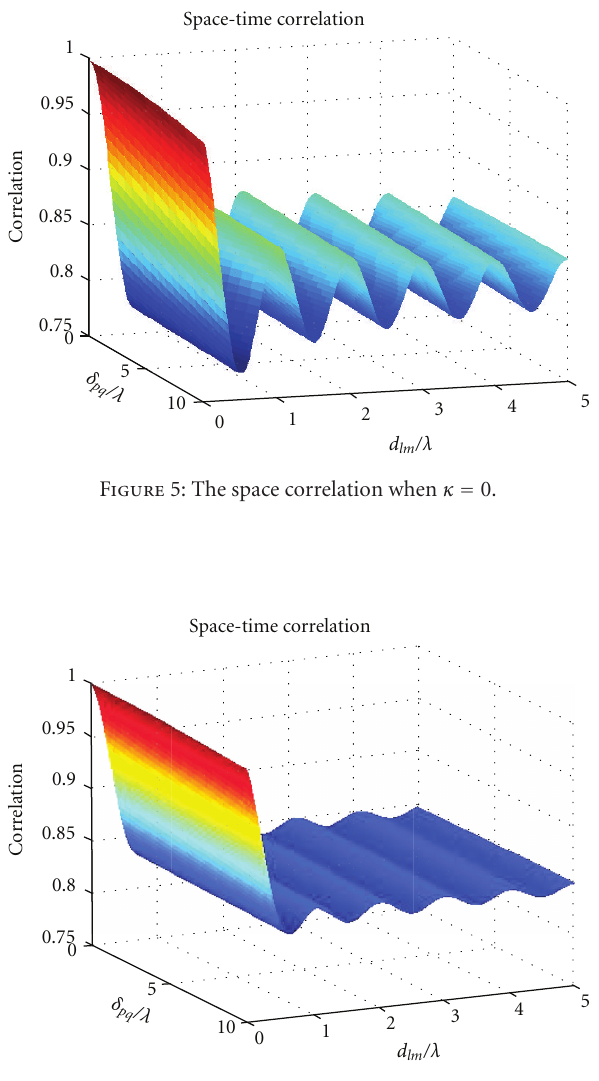
Figure 6: The space correlation when κ = 3.